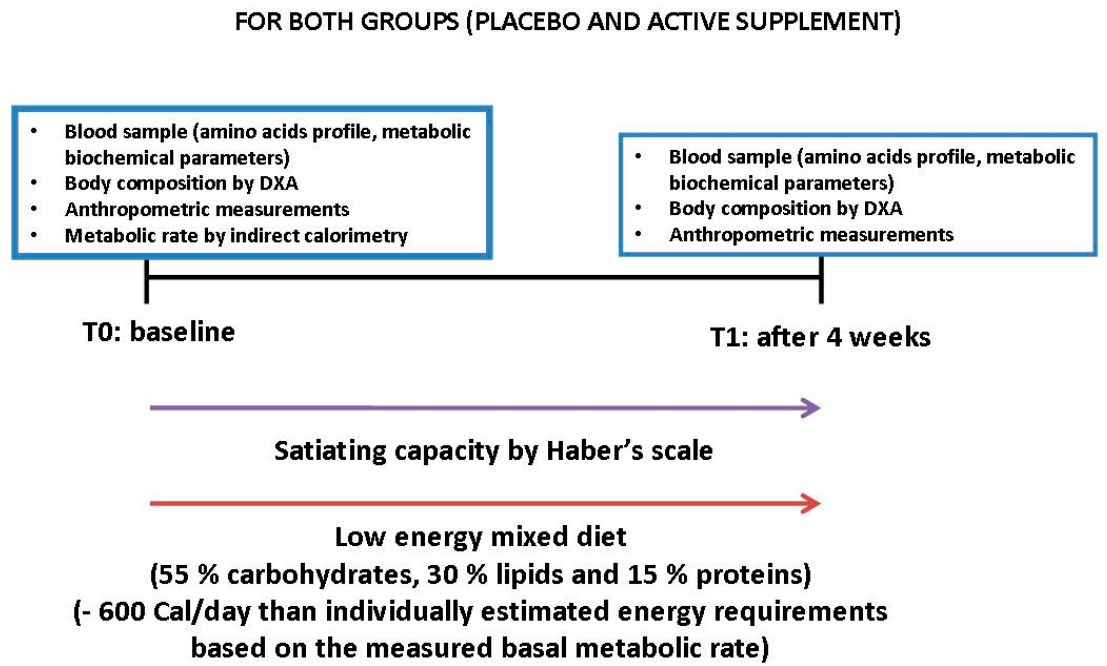
Figure 1. Trial design for the experimental and placebo groups. Abbreviations: Dual energy X-ray absorptiometry: DXA